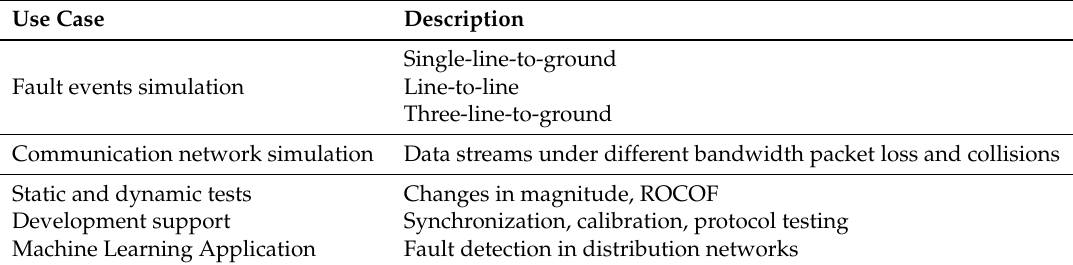
Table 1. PMU-RTS-HIL use cases’ capabilities.